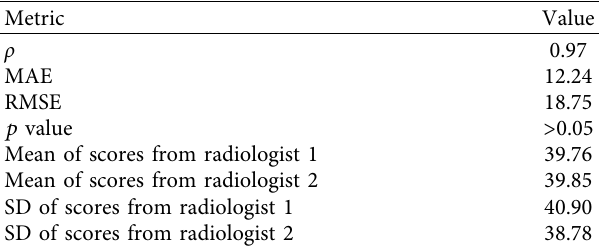
Table 2: Differences in Sharp scores given by two